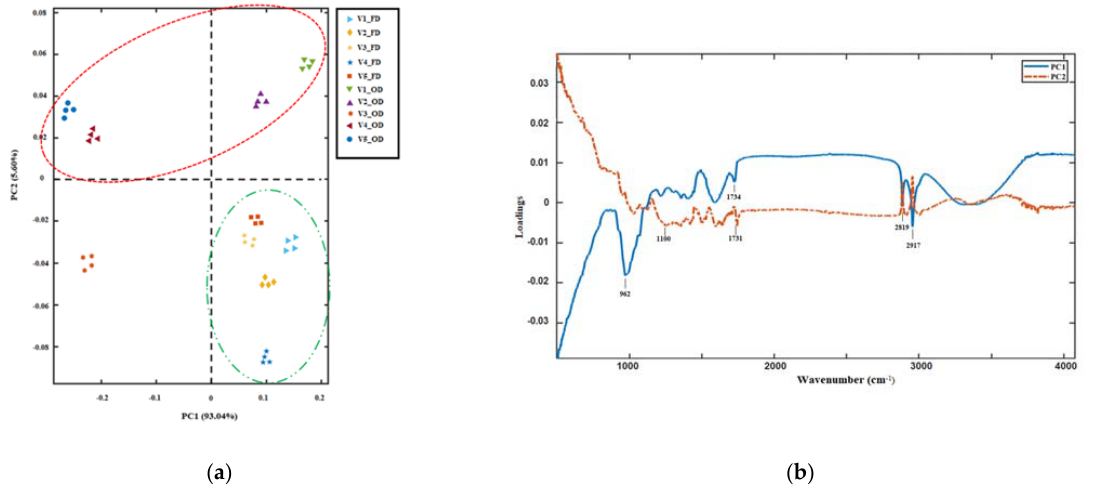
Figure 3. Principal component analysis (PCA) performed on the FTIR spectral dataset in the range 4000–800 cm − 1 : ( a ) score plot of PC1 and PC2; ( b ) loading plot of PC1 and PC2. OD samples are clustered in the red ellipse, while FD ones are in the green ellipse.